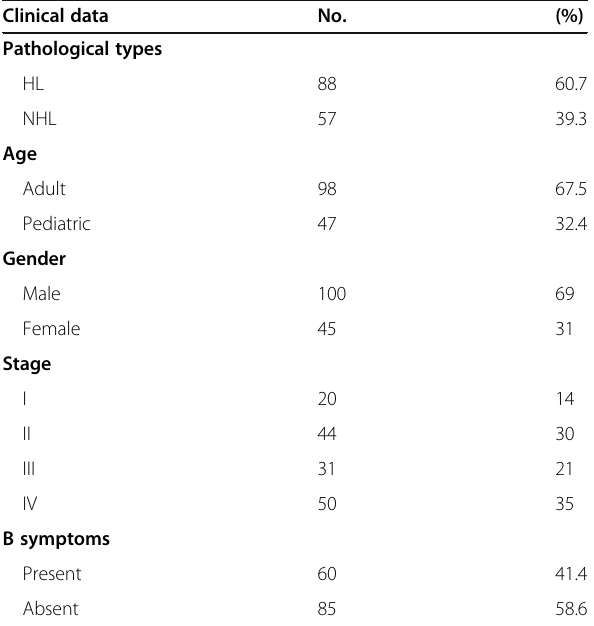
Table 1 Clinico-pathological characteristics of the whole cohort